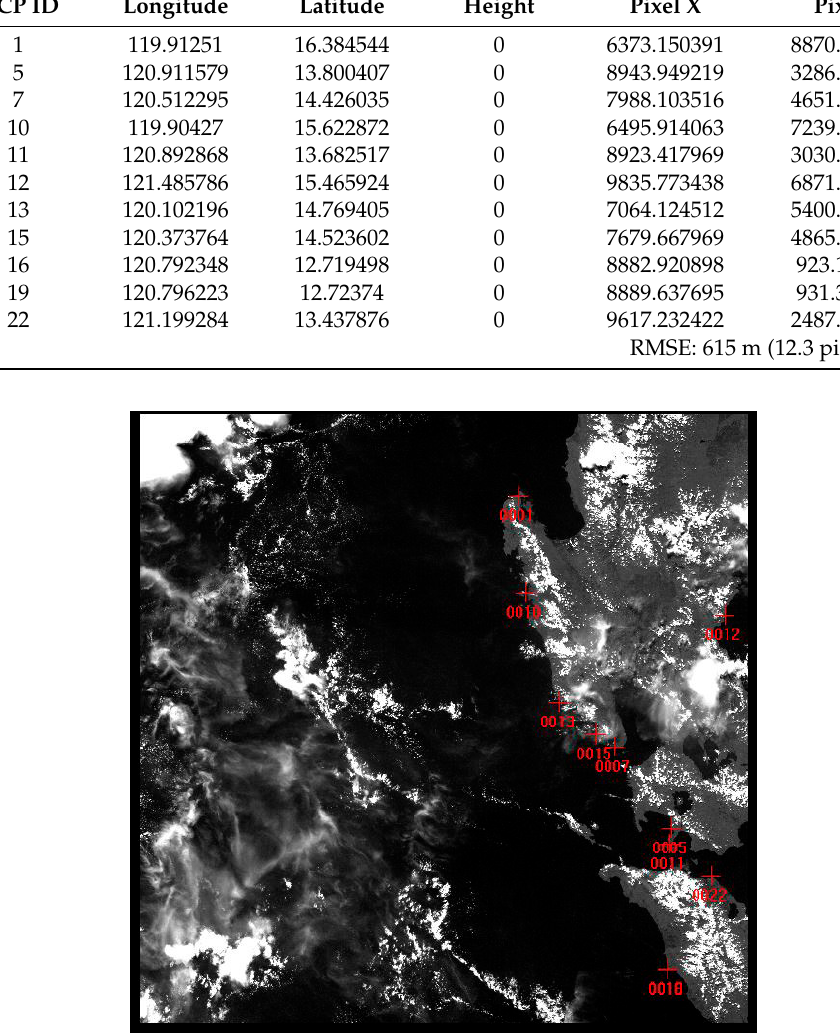
Figure 11. This shows the distribution of the selected GCPs.